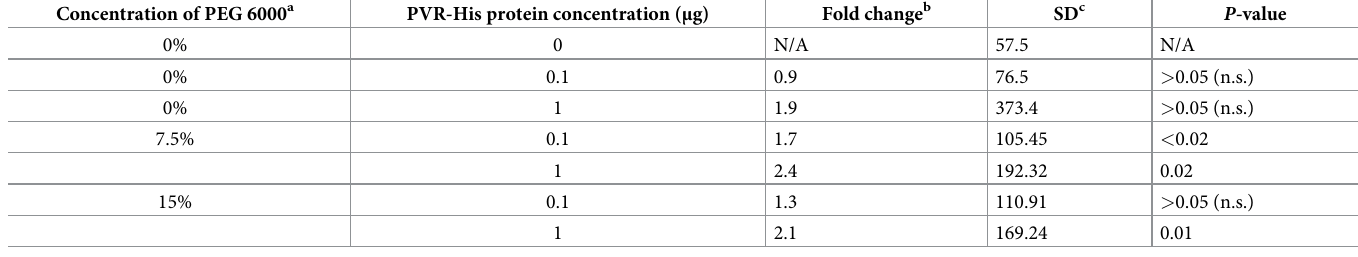
Table 3. Development of the PVR-His protein capture assay using different concentrations of PVR-His protein and PEG buffer. Fold change of mean RNA copy numbers with PVR-His capture (enrichment step) in PEG buffer were compared to extracted RNA without PVR-His addition. P -values were calculated by t -test. Quantita- tive RT-PCR was performed using 10 μ L template RNA.